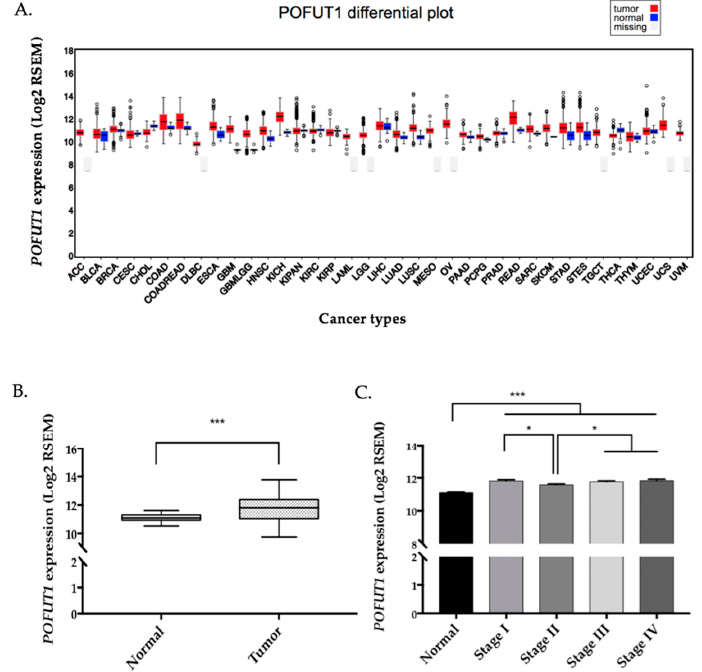
Figure 1. POFUT1 is overexpressed in most of cancer types especially in colorectal cancer from the first stage. RNAseq data from FireBrowse database show that in 22 cancer types (including COAD and READ), POFUT1 expression is higher than in the corresponding normal tissues and for 6 cancer types it is the reverse ( A ). Data are missing for nine cancer types. ACC: adrenocortical carcinoma, BLCA: bladder urothelial Carcinoma, BRCA: breast invasive carcinoma, CESC: cervical squamous cell